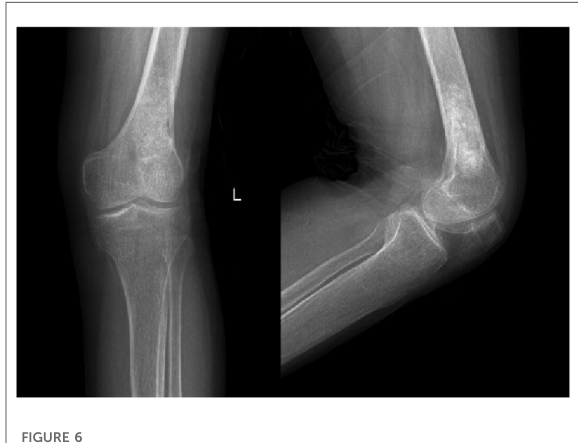
FIGURE 6 Follow-up anteroposterior and lateral radiographs of the left knee 6 months after the surgery showing good recovery of the left distal femur, consistent with postoperative changes of the left distal